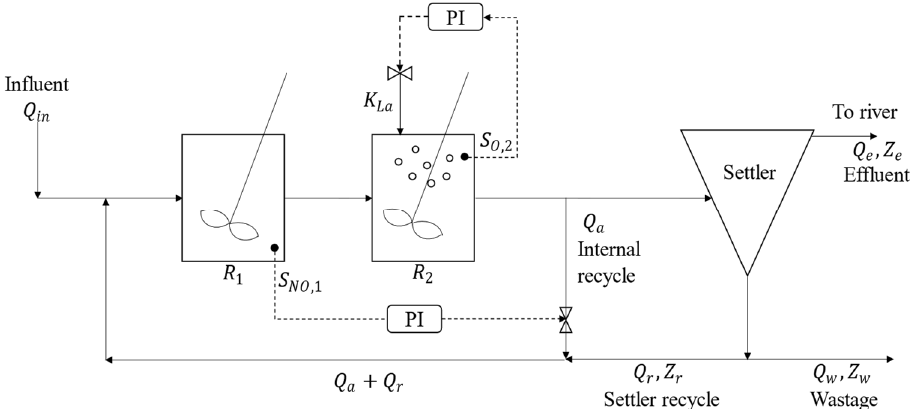
Figure 2. Schematic representation of the controlled 20th-order model.